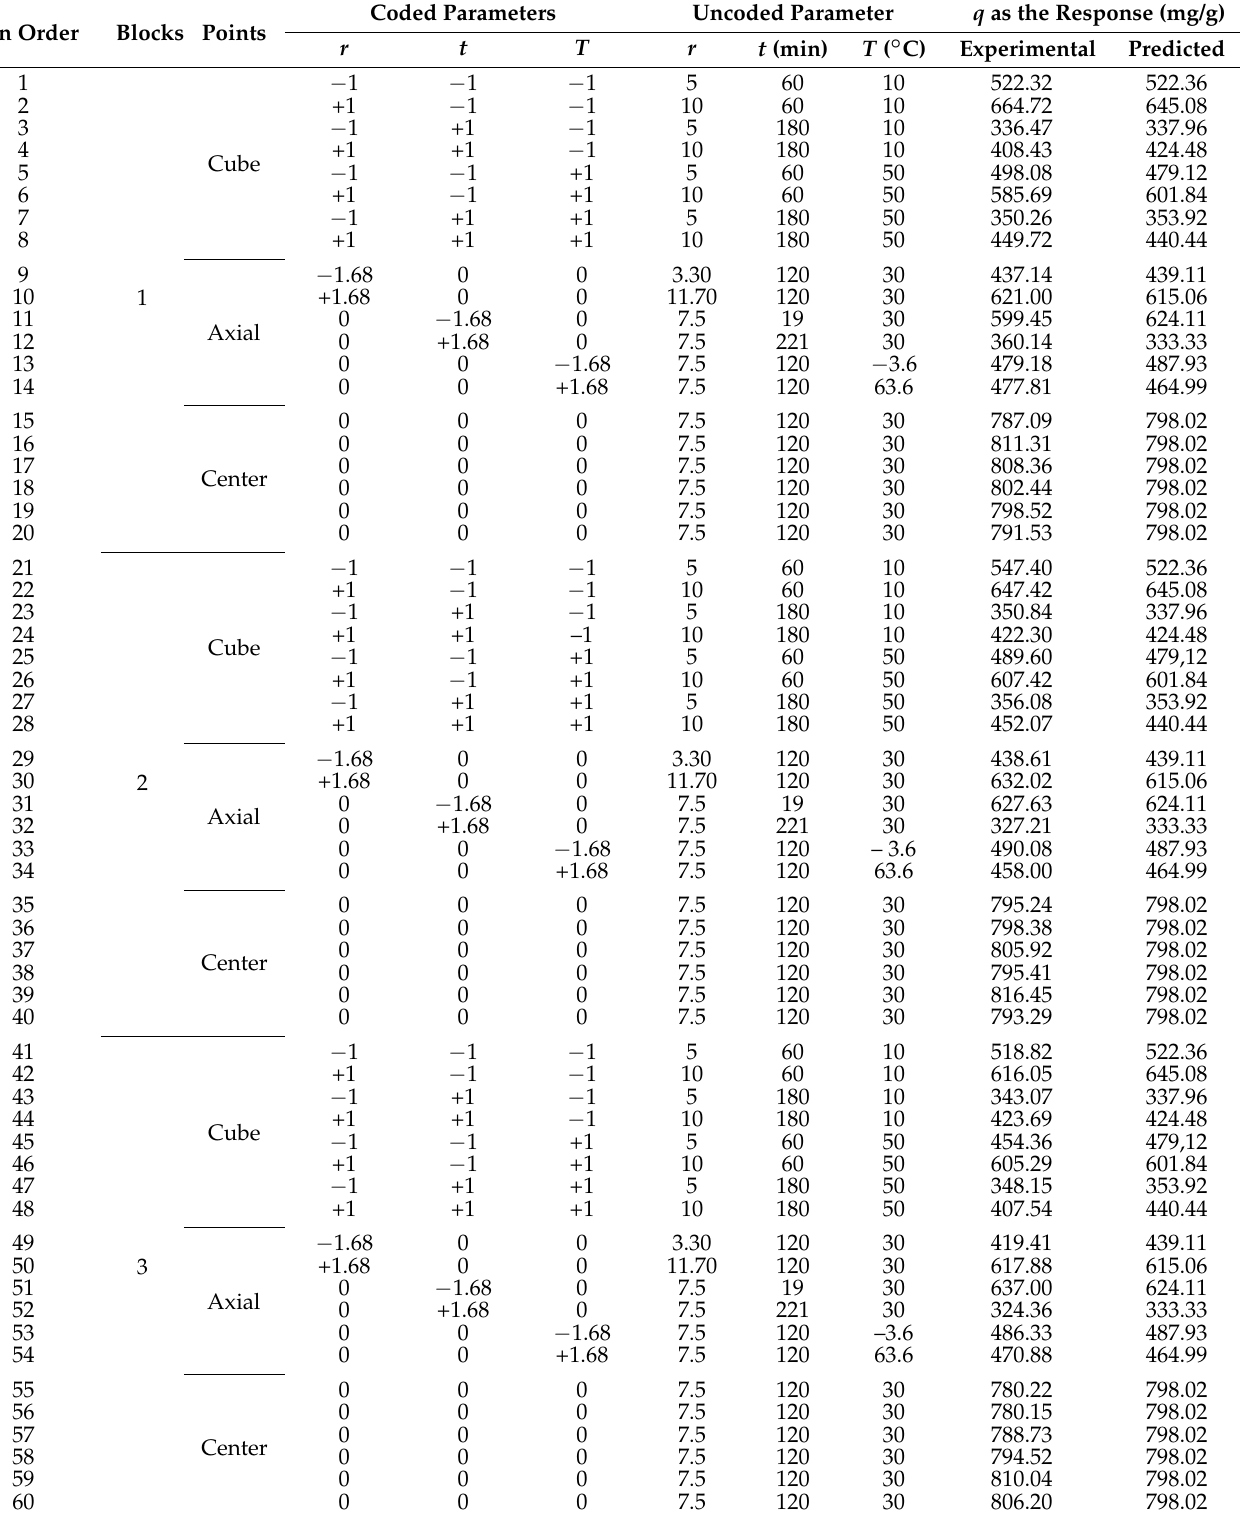
Table 1. Design of the experiment on the ZIF-L synthesis, along with the experimental and predicted responses. Run